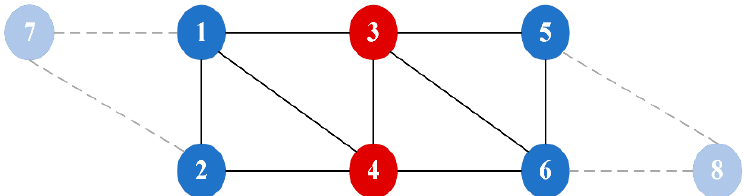
Figure 5. An example of six DG units connected based on Triangle mesh communication topology.